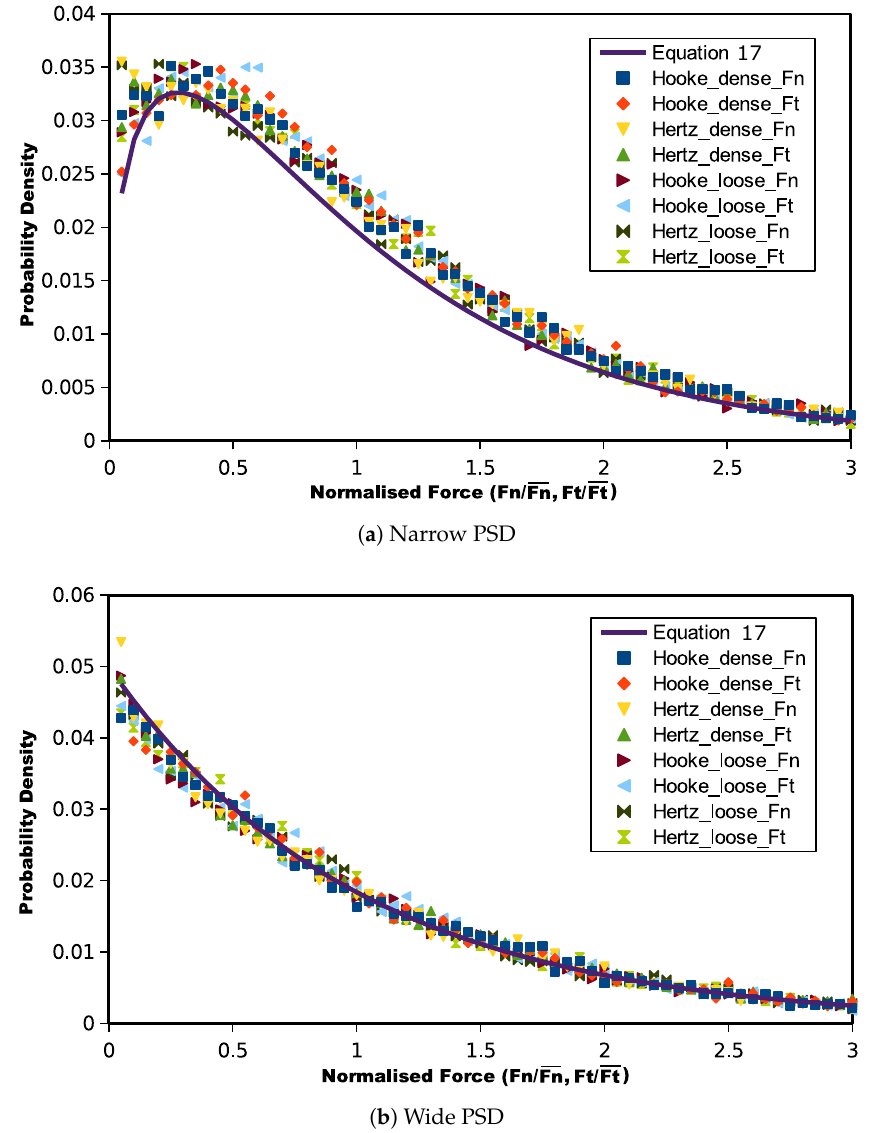
Figure 8. Unique critical state contact force distribution of different contact